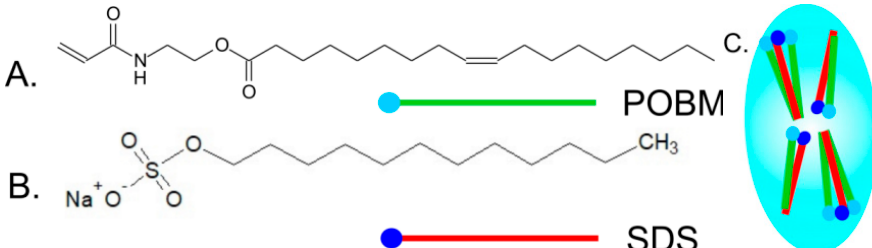
Figure 14. Chemical structure of plant oil-based monomer ( A ), surfactant ( B ), and schematic of POBM solubilization by SDS molecules ( C ). Reprinted from [36]. Copyright (2019), with permission from Elsevier.